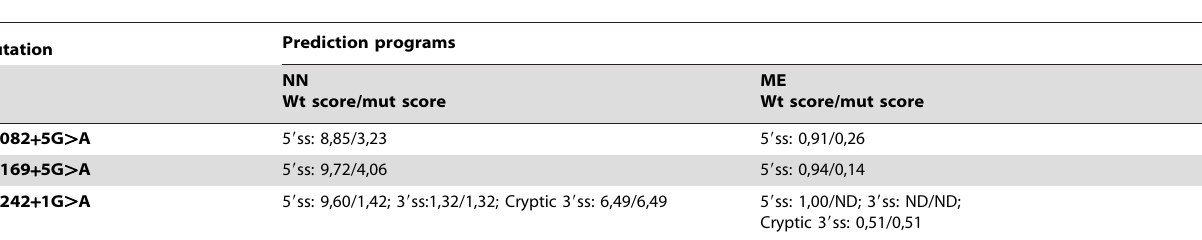
Mutation Prediction